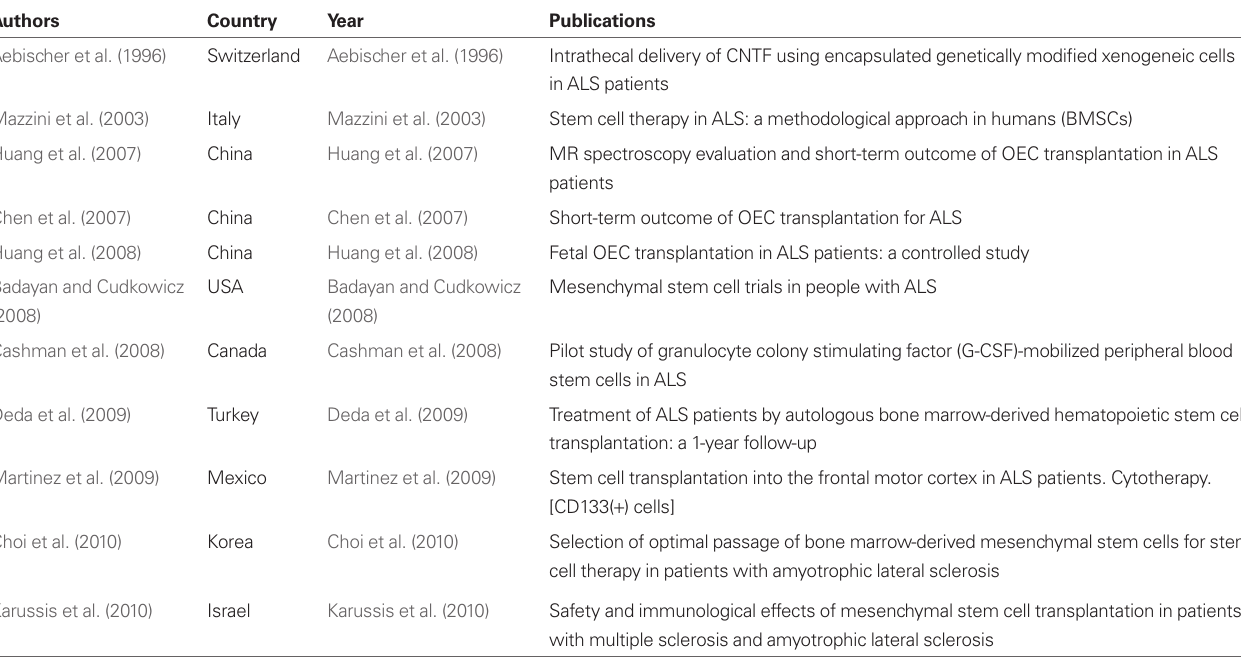
Table 2 | Literatures of cell-based therapy in ALS humans (data from Pubmed; modified from 5). Authors